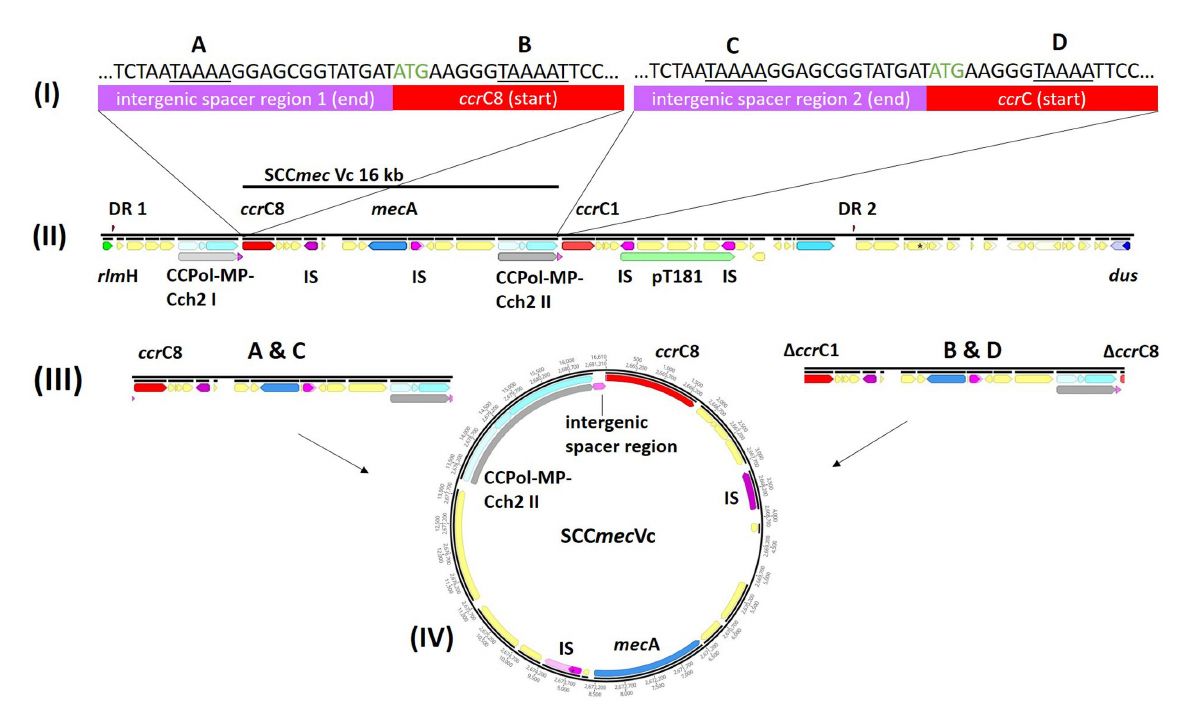
FIGURE 3 Tracking the loss of SCC mec Vc. MRSA ST398 IMT38951: Illustration of the SCC mec integration site downstream of rlm H. (A) Comparison of the terminal sequences of the intergenic sequences spacer region 1 (I) and 2 (III) and the initial basepairs of ccr C8 (II) and ccr C1 (IV) (start codon: green) revealed two possibilities of homologues recombination after deletion of SCC mec: A & C, intergenic regions 1 and 2; and B & D, ccr C8 and ccr C1. (B) The region between rlm H (previously “ orf X“) and dus (previously orf Y) carries various repetitive DNA sequences. (C) Both recombination events would allow deletion of an identical and complete SCC mec Vc element. (D) Circular SCC mec element with putative functional recombinase ccr C8 and a CCPol-MP-Cch2 II complex (Bebel et al., 2020) conferring its autonomous replication capabilities. ccr , chromosomal cassette recombinase; IS, insertion sequence; DR, directs repeats associated with ccr -mediated integration and excision of SCC mec elements (Semmler et al.,